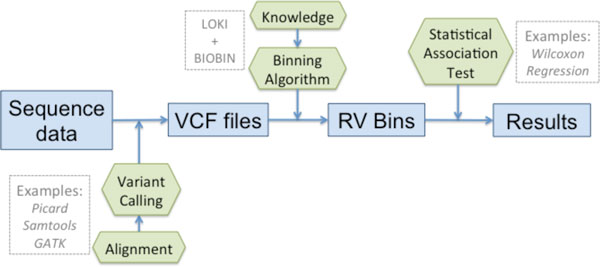
Pipeline for BioBin analysis. Blue squares correspond to data, green hexagons correspond to bioinformatic or statistical method applications.